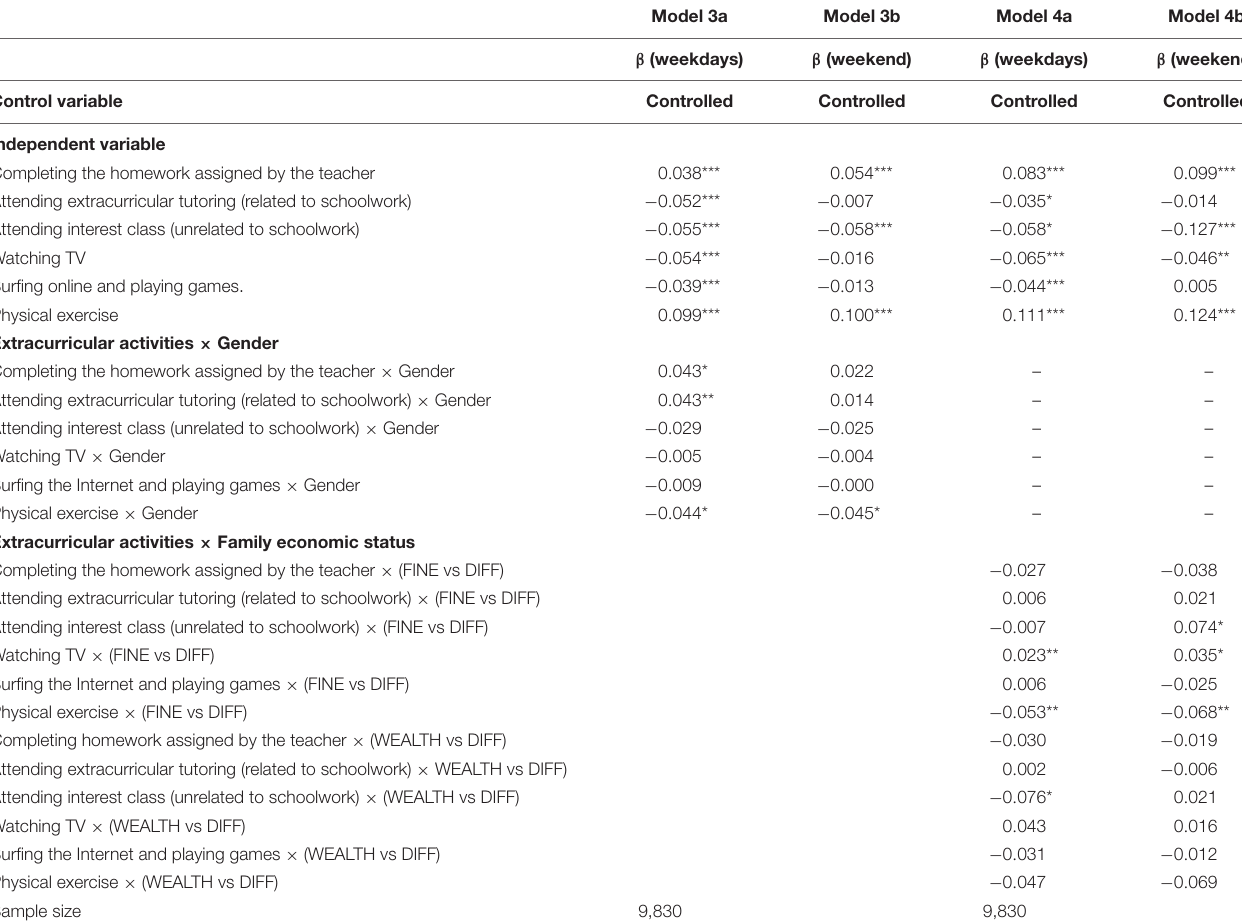
TABLE 4 | Fixed effect model of extracurricular activities on junior high school students’ cognitive ability (adding interaction variables).